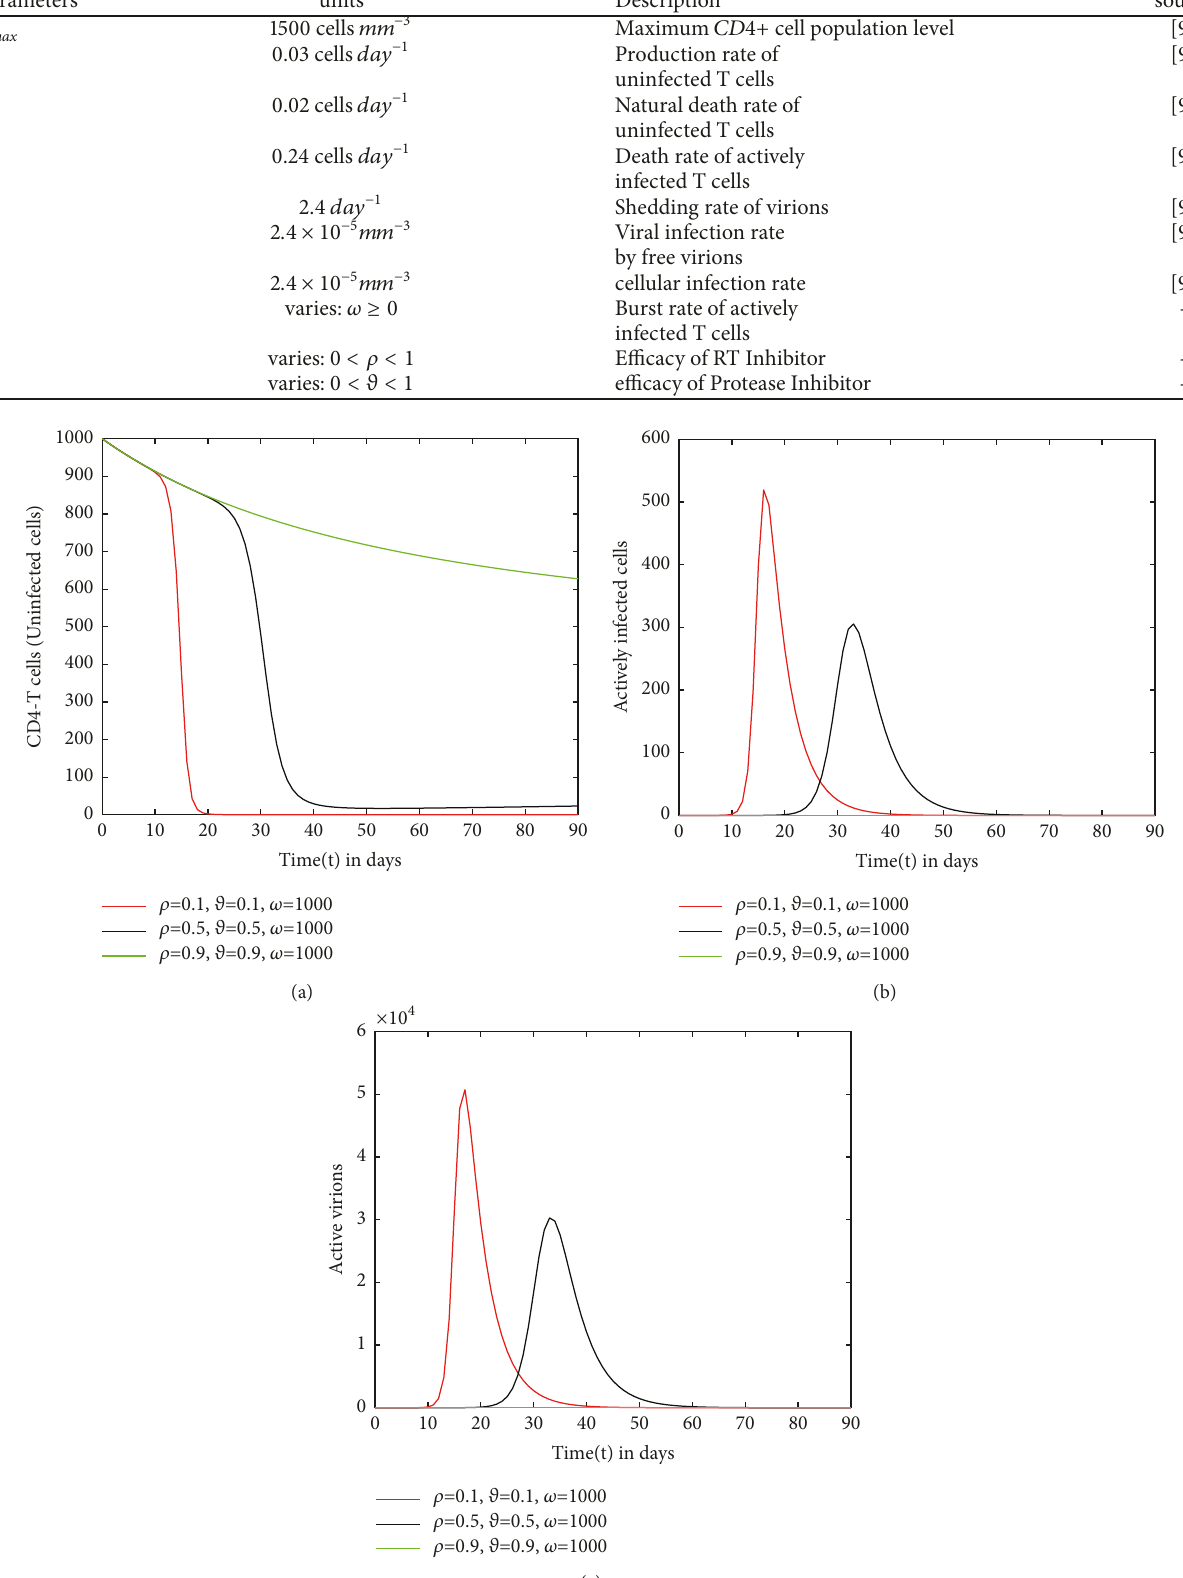
Figure 1: Effect of treatment efficacy on 𝑇(𝑡),𝑇 ⋆ (𝑡) , and 𝑉(𝑡)